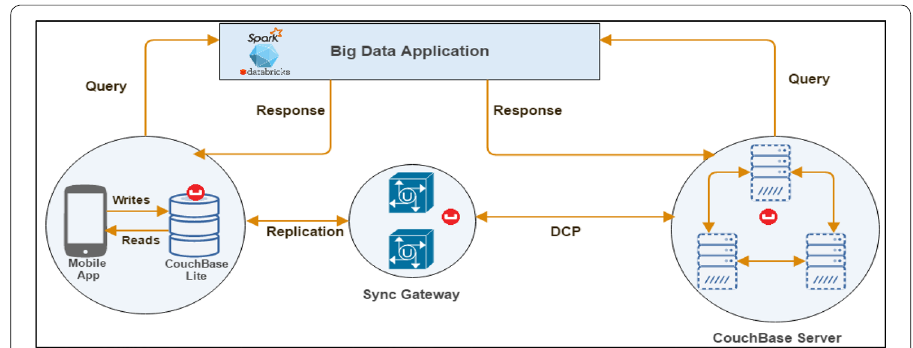
Fig. 6 Overview of our system